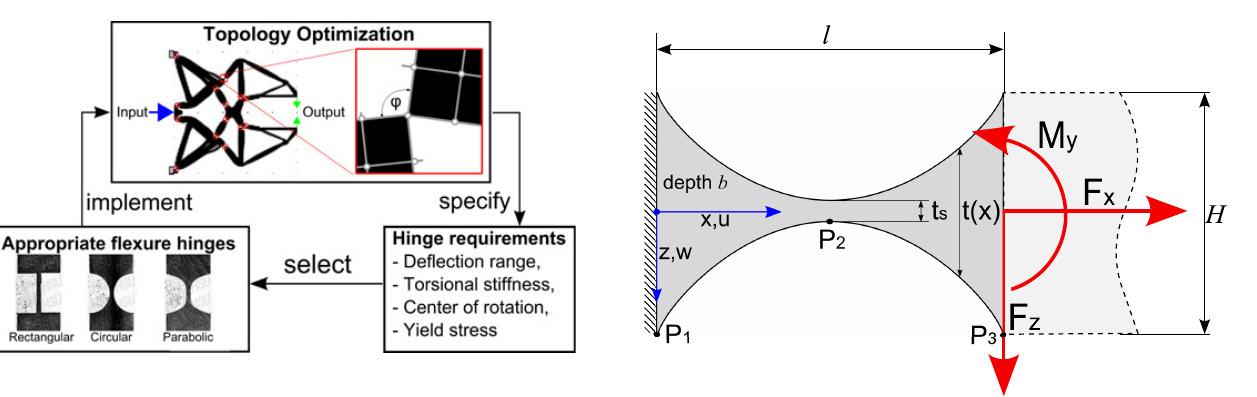
Figure 1. Beneficial procedure for non-intuitive synthesis of com- pliant mechanisms: Replacing artificial one-node hinges by appro- priate flexure hinge types meeting specified, known hinge require- ments.